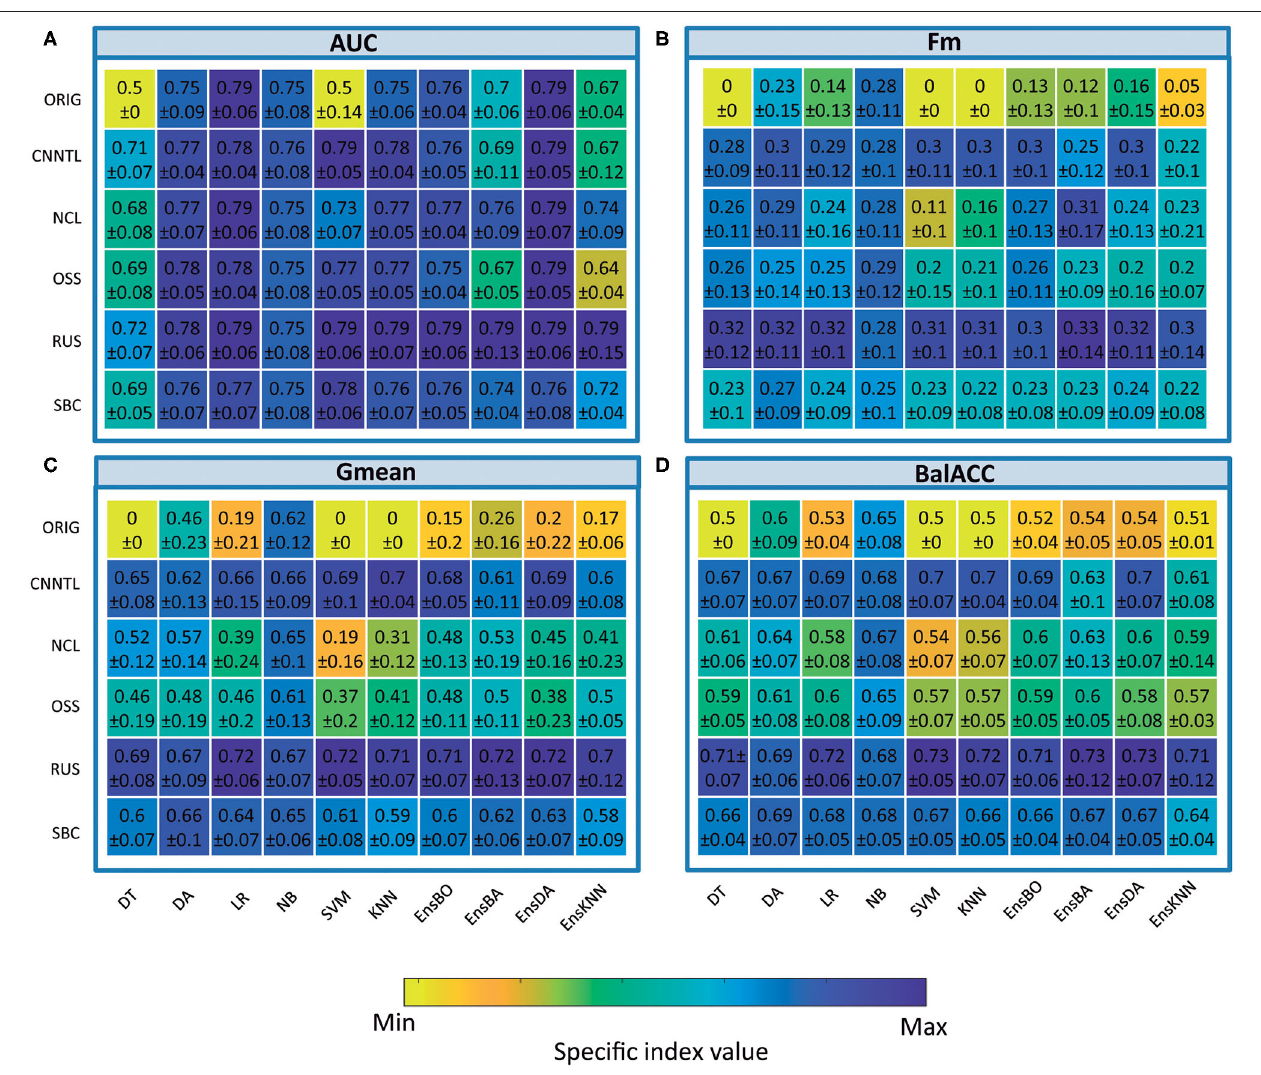
FIGURE 3 | Comparison of classifier performances (mean and SD), among the different undersampling procedures, in terms of indices AUC (A) , Fm (B) , Gmean (C) , and BalACC (D) . X -axis: classifiers applied; Y -axis: resampling techniques. For ease of understanding, the colormap spans from minimum to maximum values of each specific index. As shown in Table 3 and Supplementary Tables 6 – 9 for statistical comparisons among these